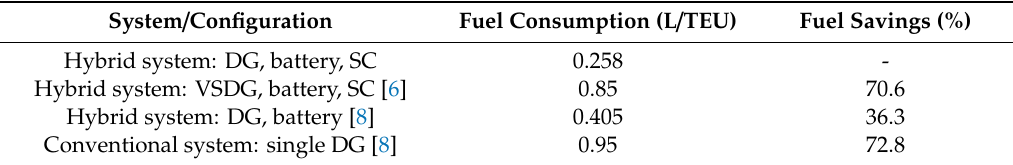
Table 4. Fuel consumption and fuel savings.